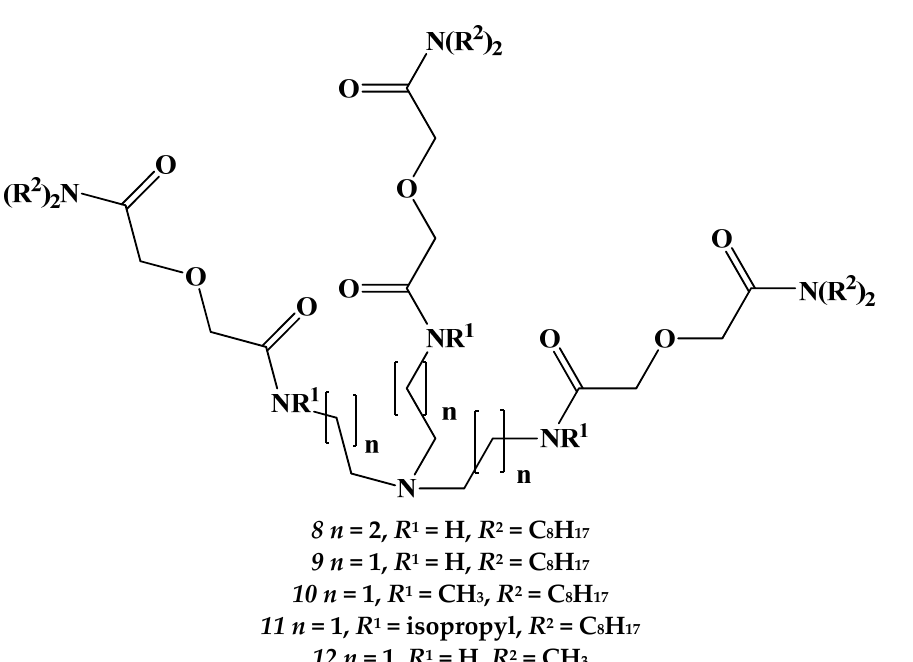
Table 2. Distribution ratios and separation factor data β Am/Me (given in